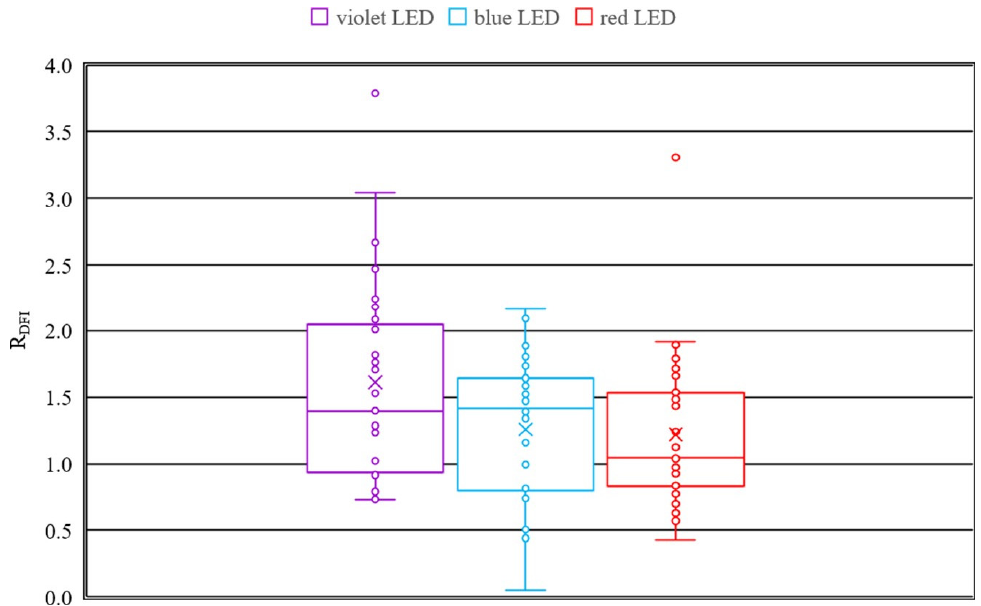
Figure 5. Comparison of the pixel change in the dark field images according to Equation (7) of the lenses irradiated with violet, blue and red LEDs.